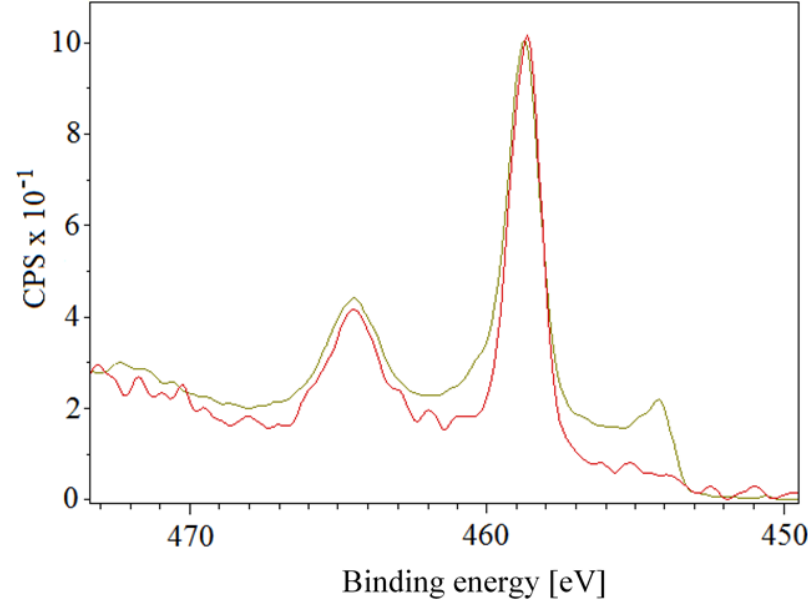
Figure 9. Representation of titanium oxide in the surface layer determined by XPS; two different angles, 9°, and 90°, were used for an unheated sample with sputtered 2 and 28 nm layers of gold and titanium, respectively. The red and green curves show measurements at the angles of 9° and 90°, respectively.